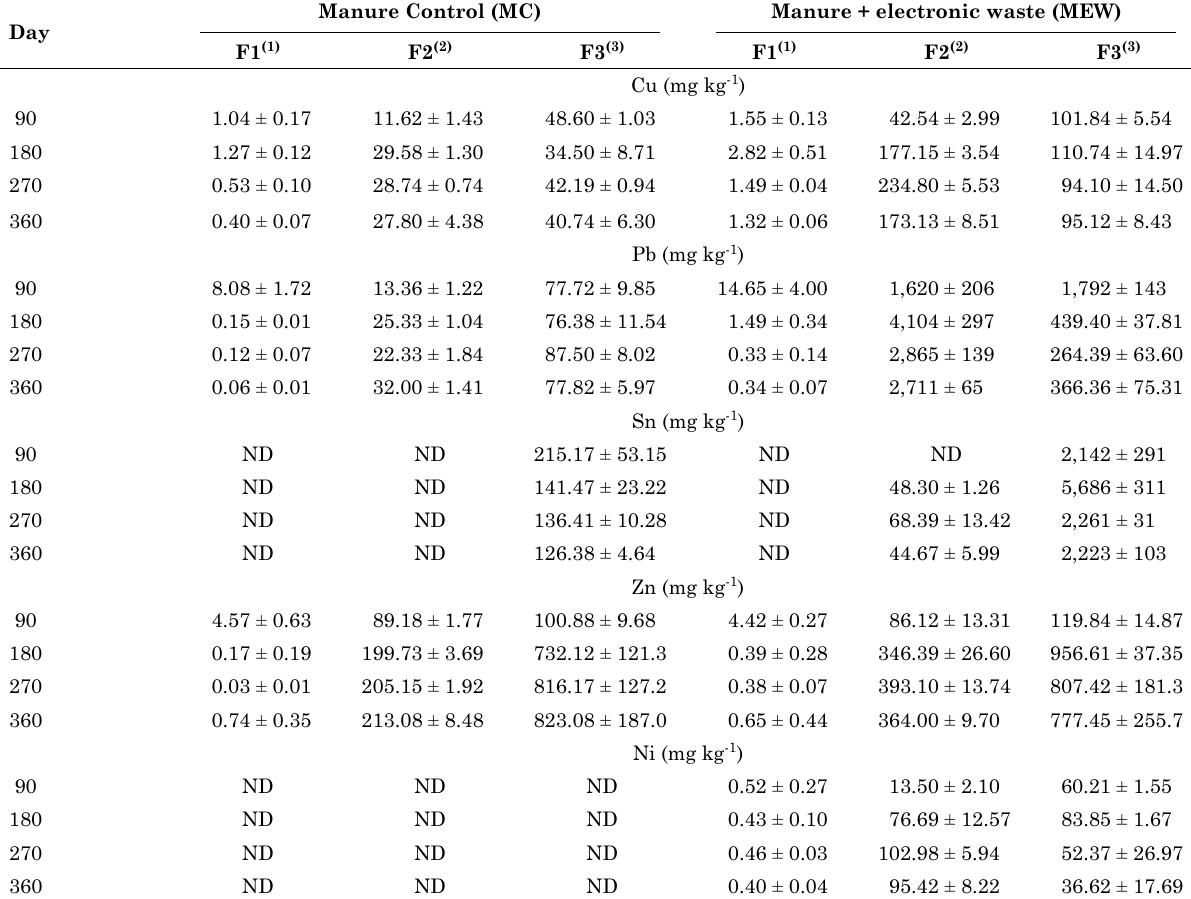
table 1. metal concentrations determined by sequential extraction (f1, f2 e f3) of the compost obtained from cattle